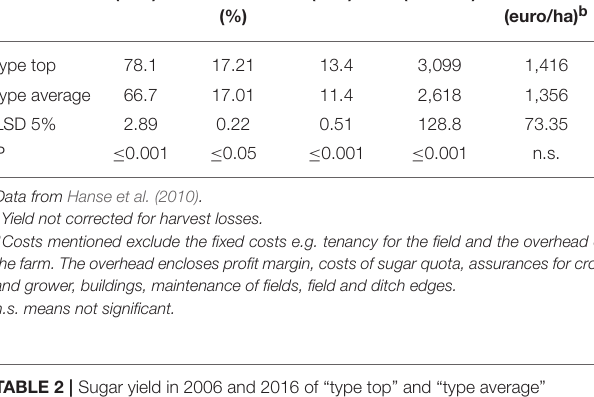
TABLE 1 | Influence of grower type on yield and costs in Dutch sugar beet production; SUSY-project, 2006–2008. Grower